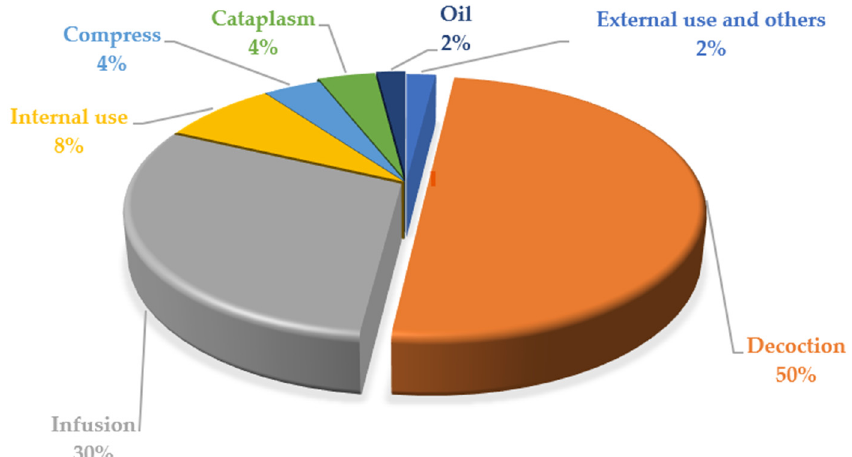
Figure 3. Preparations of the herbal drugs (percentage).